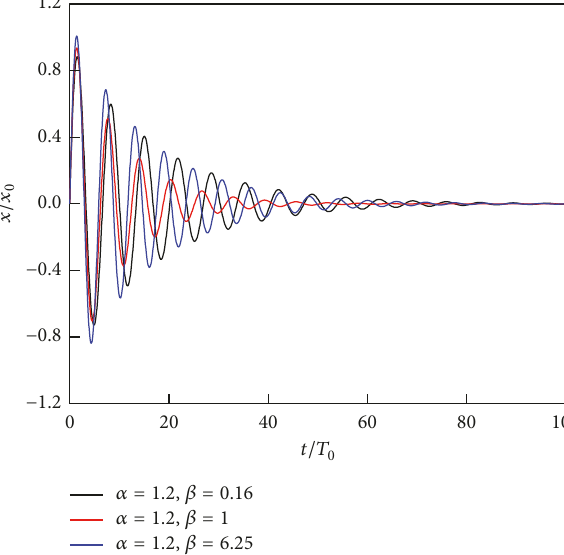
Figure 32: Response in the time domain ( 𝛼 = 1.2, 𝛽 = 0.16, 1, 6.25